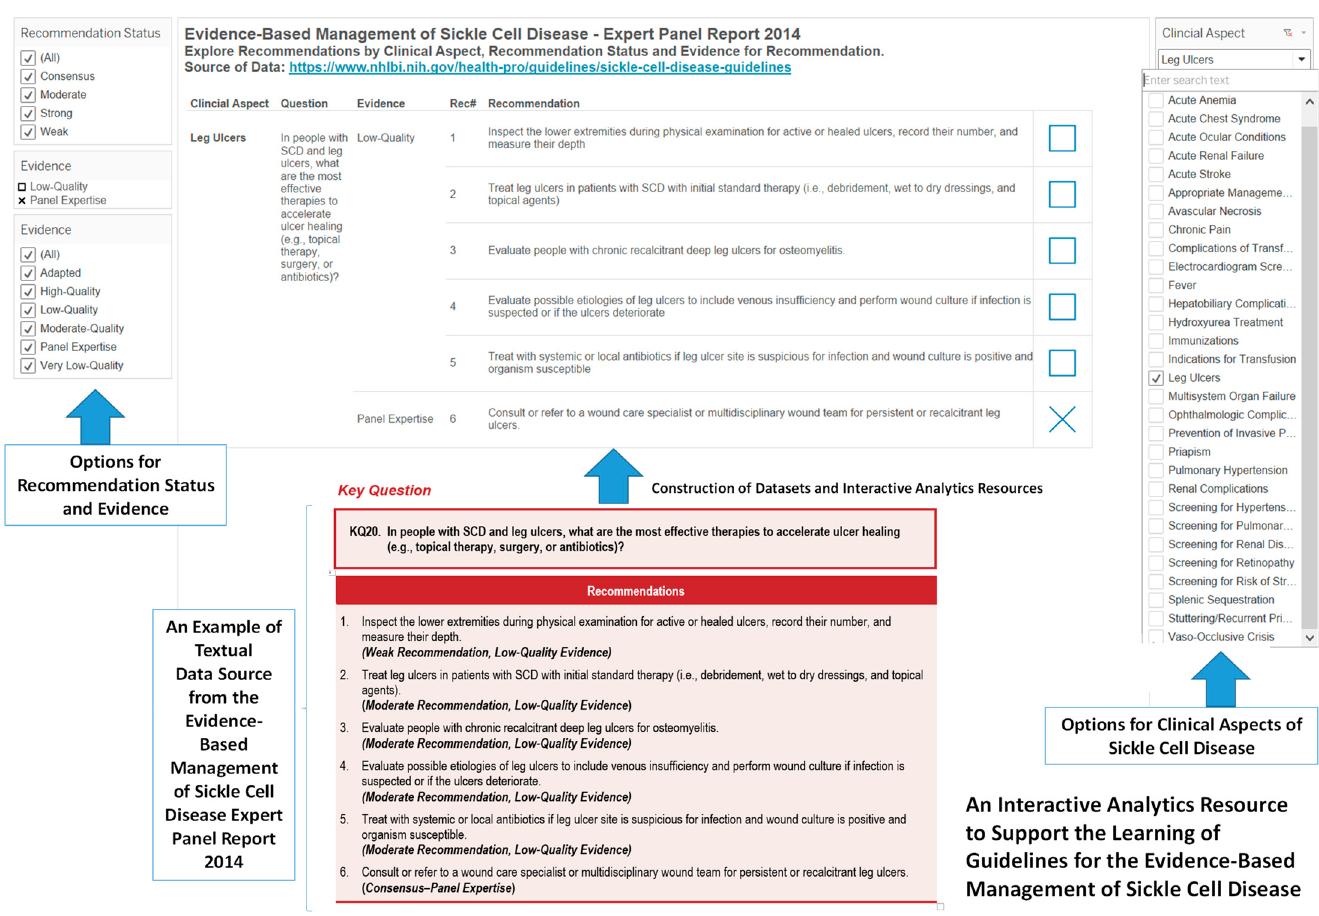
Figure 8. An example design of an interactive analytics to support the learning of guidelines for the evidence-based management of sickle cell disease. In this example, the key question and recommendations for evidence-based management of leg ulcers is included to show the textual data source.